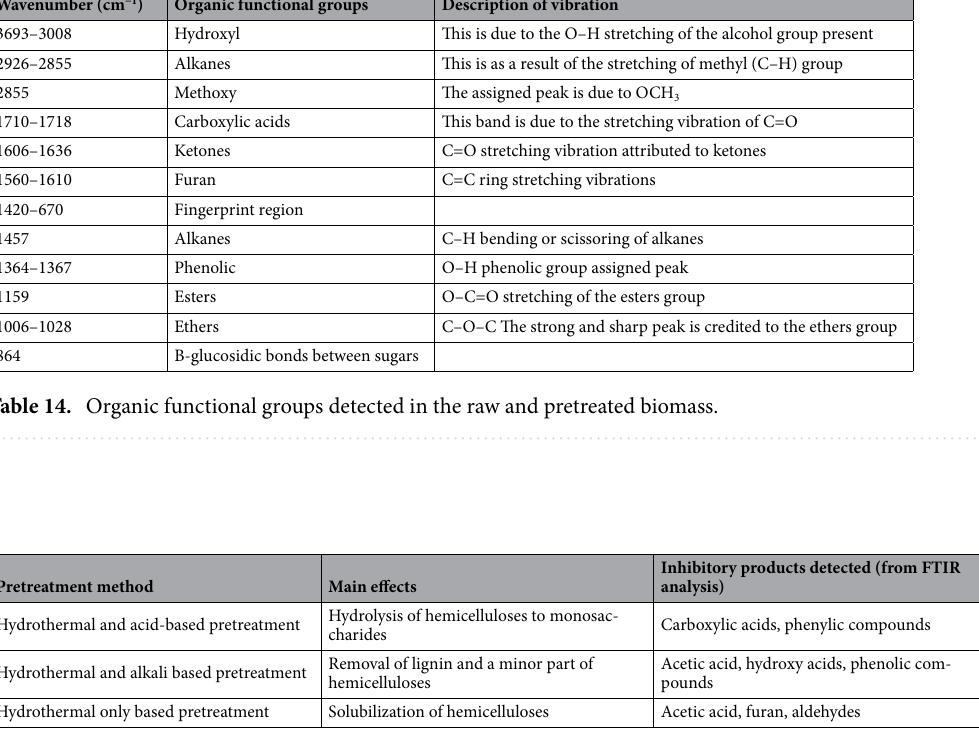
Table 15. Summary of inhibitory side products formed during the different pretreatment